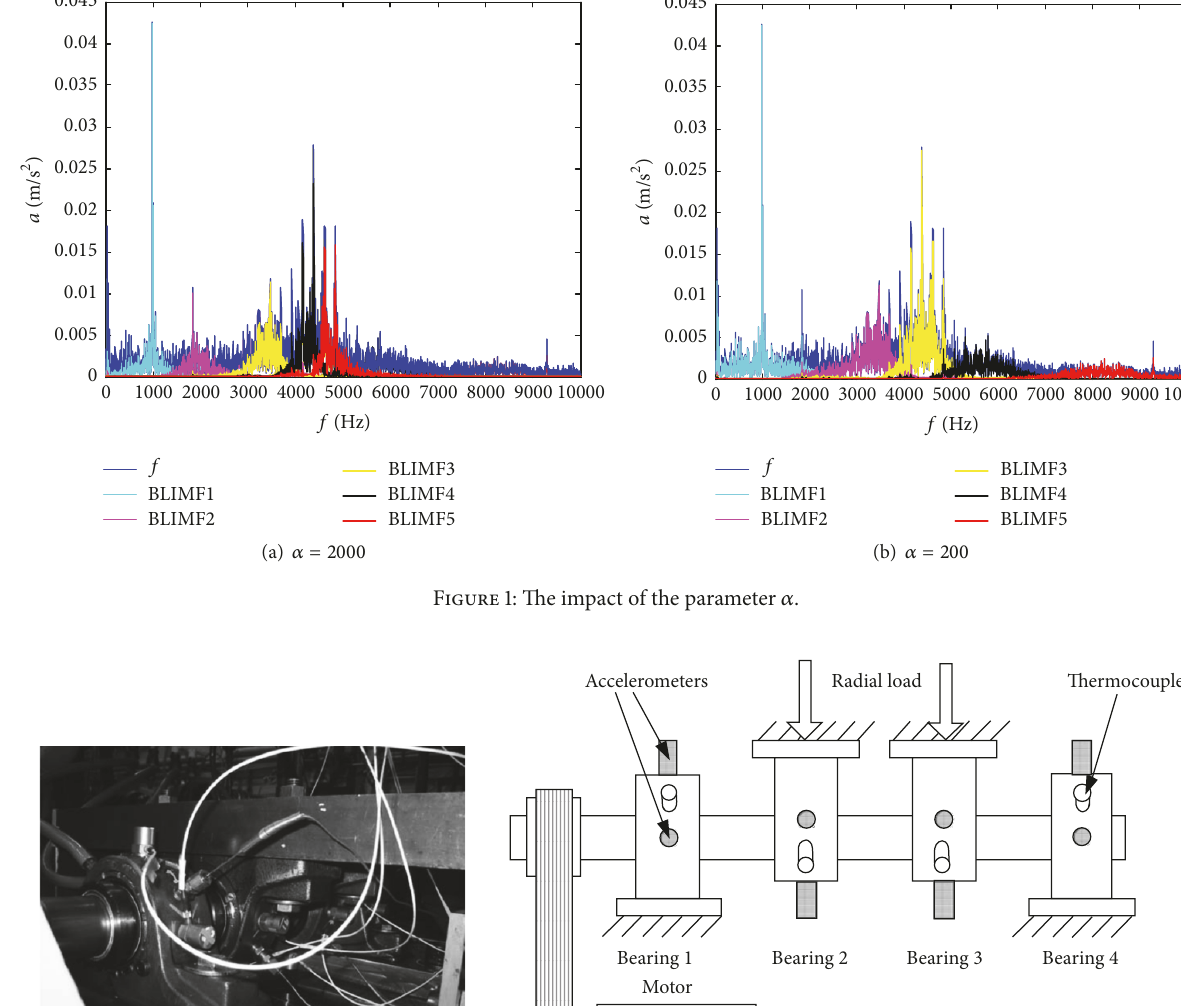
Figure 2: Bearing test